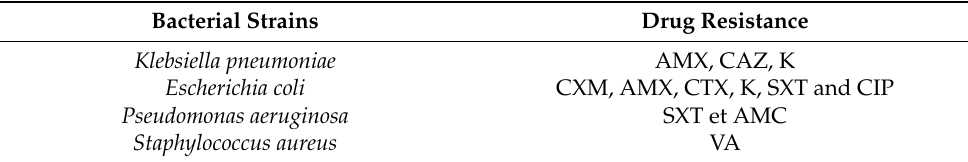
Table 3. List of drug resistance applied to the studied bacteria. Bacterial Strains Drug Resistance Klebsiella pneumoniae AMX, CAZ, K CXM, AMX, CTX, K, SXT and CIP Pseudomonas aeruginosa SXT et AMC